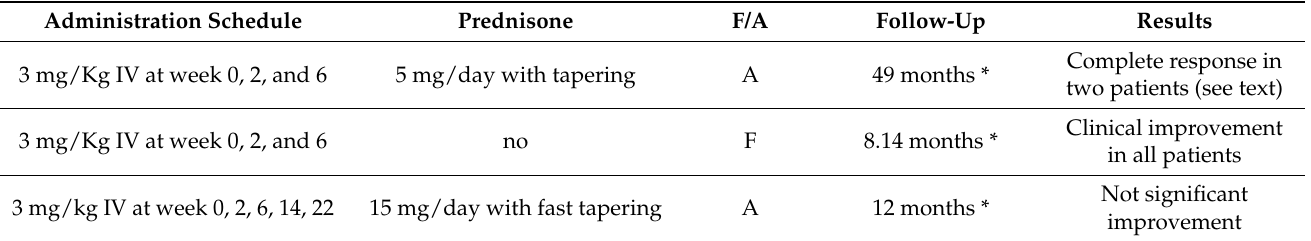
Table 2. Infliximab in patients with PMR: administration schedules, follow-up and